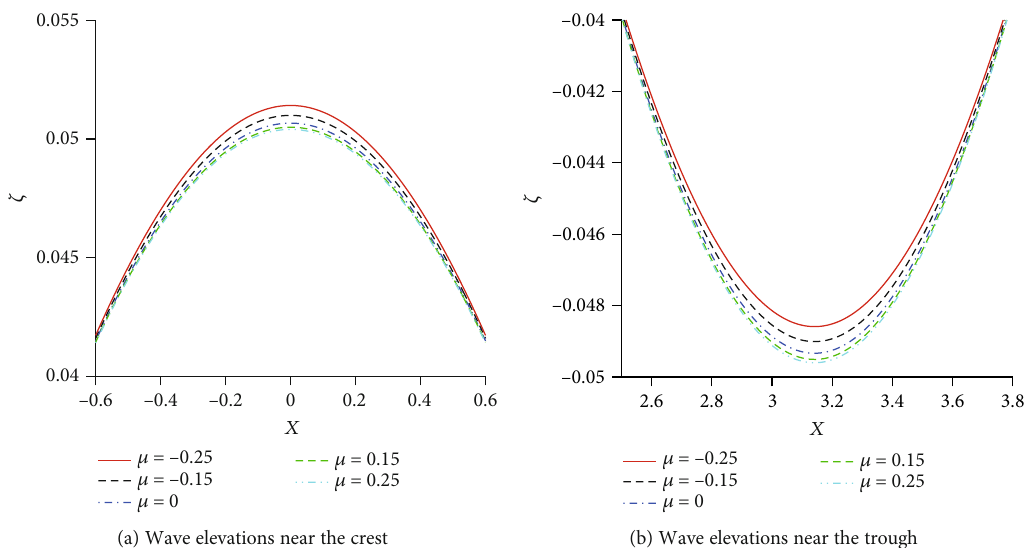
Figure 3: Variation of the hydroelastic wave pro fi les versus x for di ff erent vorticity parameter μ .